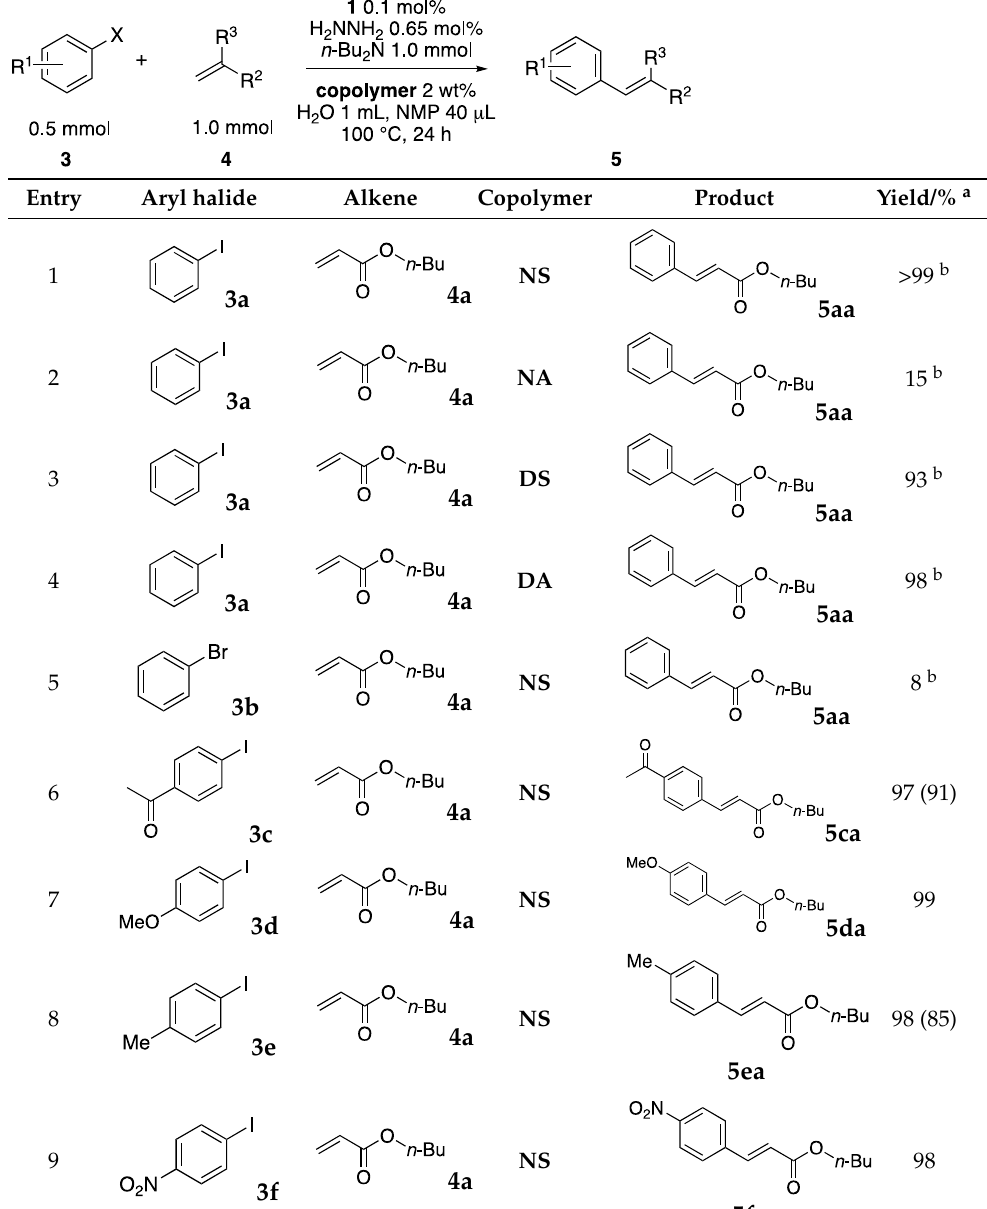
Table 3. Mizoroki–Heck reactions with various aryl halides and alkenes in water.